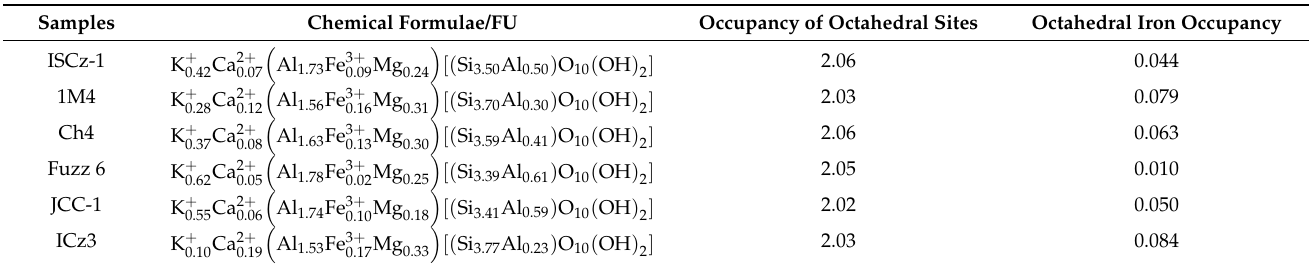
Table 4. Chemical formulae and octahedral information of Ca-saturated samples (<0.2 µ